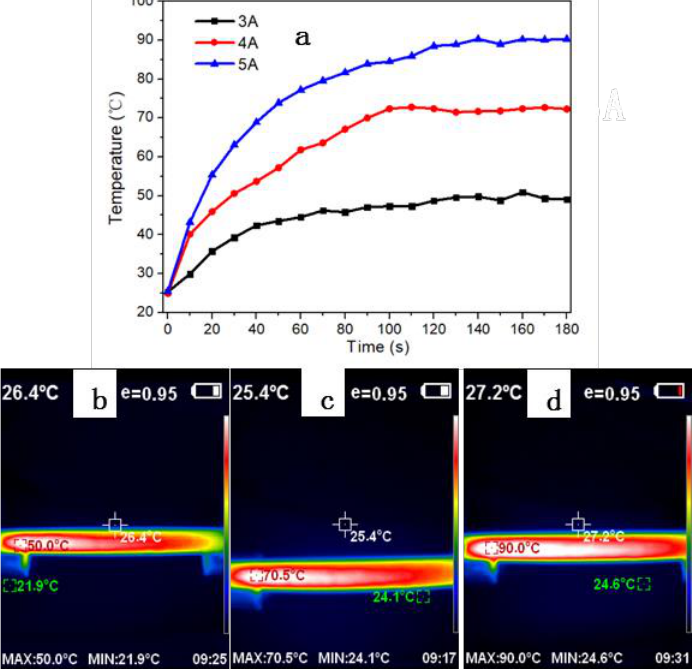
Figure 2. Infrared thermal imaging of CF/EP plates with different conduction currents: ( a ) The temperature response to the current loading time; the typical infrared photograph of the samples under the current loading of ( b ) 3 A, ( c ) 4 A and ( d ) 5 A.